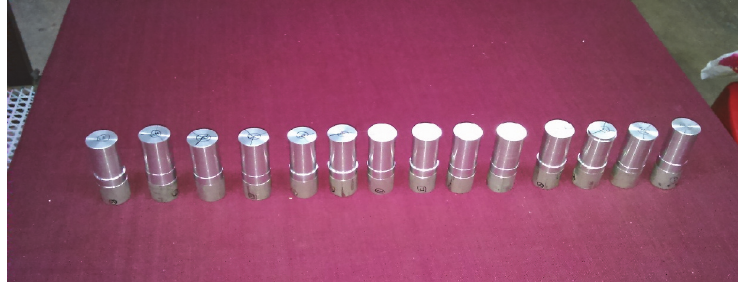
Fig. 1. Photographic view of machined